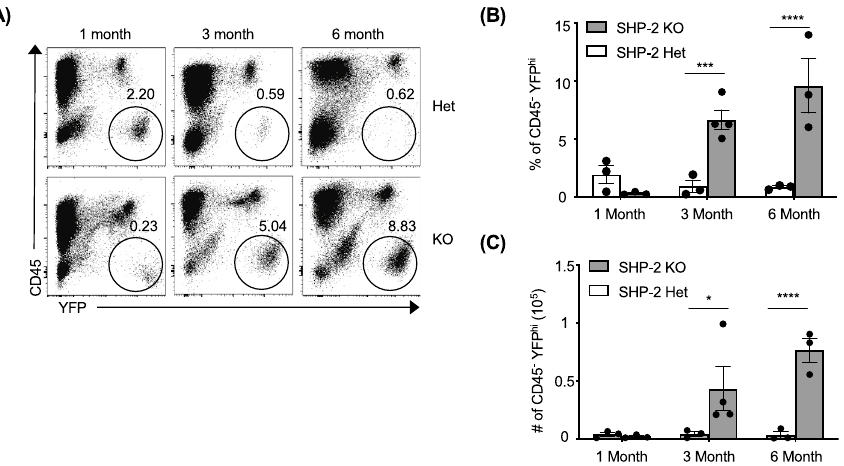
Figure 1. Increases in non-hematopoietic YFP + cells correlate with progression of wrist tumors. ( A ) Representative staining of cells isolated from the wrists of Het and KO animals at 1, 3 and 6 months of age. ( B ) Frequency and ( C ) total number of CD45 − YFP + cells (black circled population in panel ( A ) isolated from the wrists at each time point (n = 3–4). Data are from a single experiment and represent mean ± SEM. *p < 0.05, **p < 0.01, ***p < 0.001, and ****p < 0.0001. See also Figure